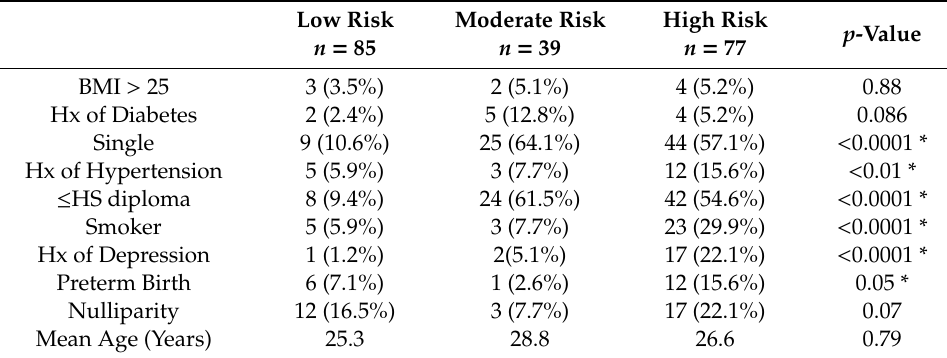
Table 3. Baseline characteristics of stratified sample ( n =